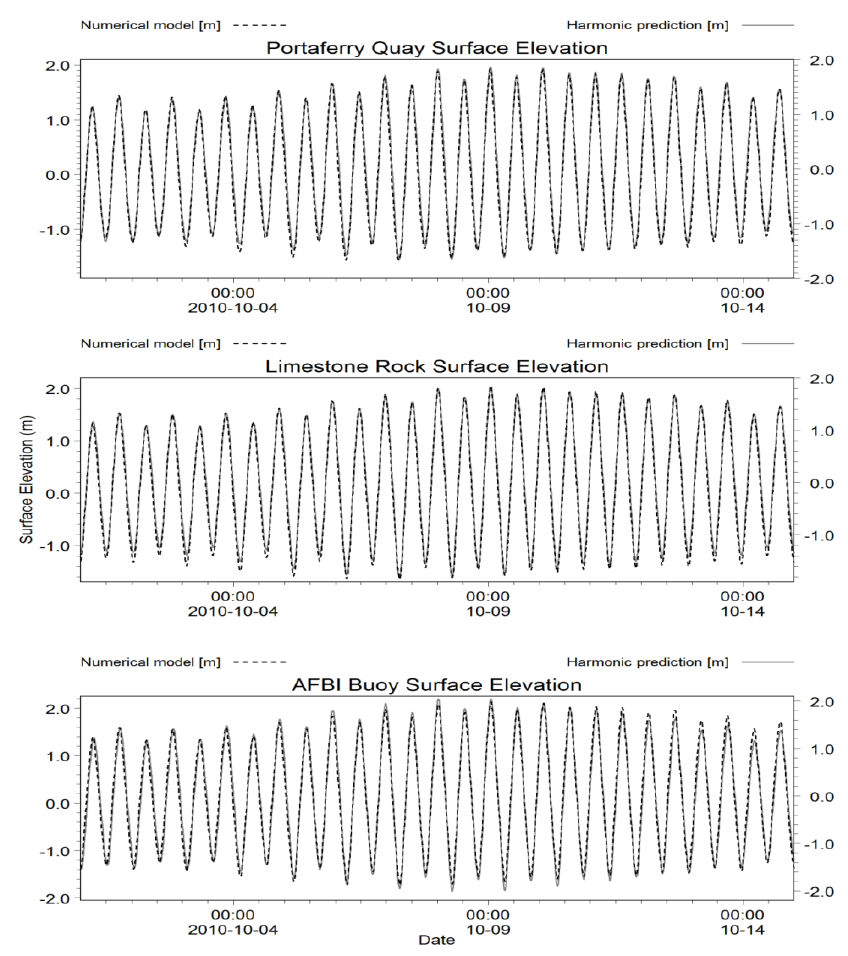
Figure 7. Comparison of surface elevation between the harmonically predicted and numerical model at: Portaferry Quay, Limestone Rock and the AFBI buoy during the period 1–14 October